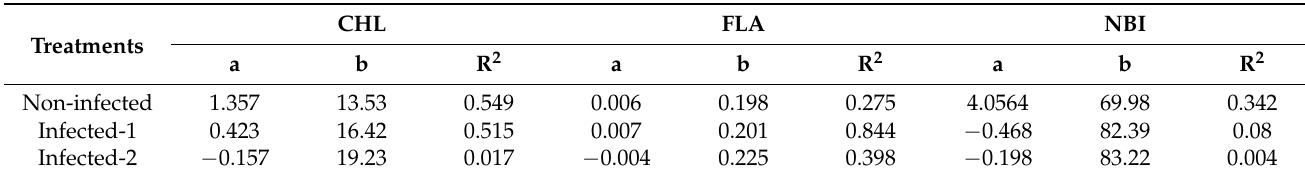
Table 1. Coefficients for linear regression equations presented in Figure 1, in the form of y = ax + b, and their correlation coefficients (R 2 ).